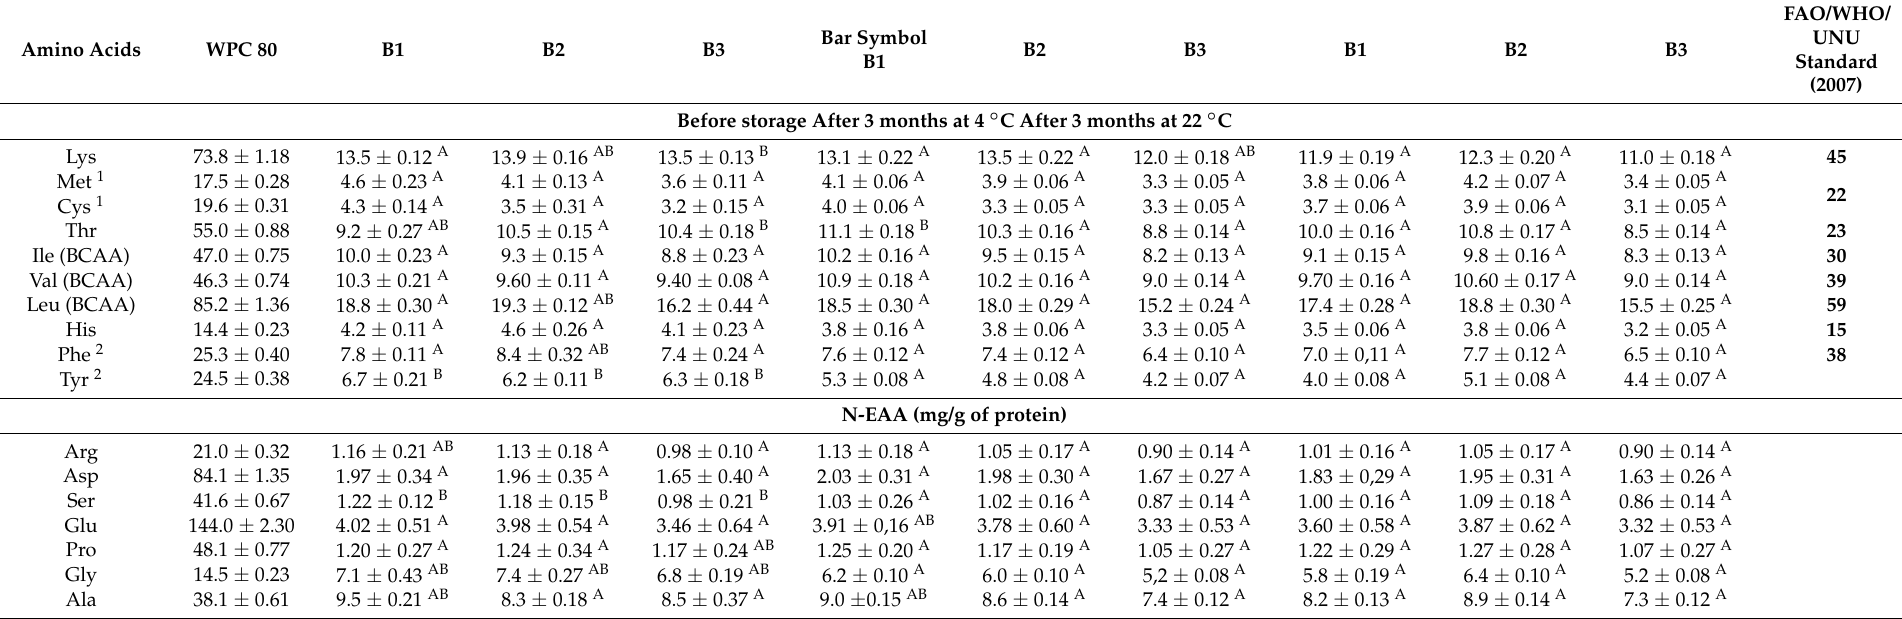
Table 3. Amino acid composition of prepared organic protein snack bars of depending on the storage